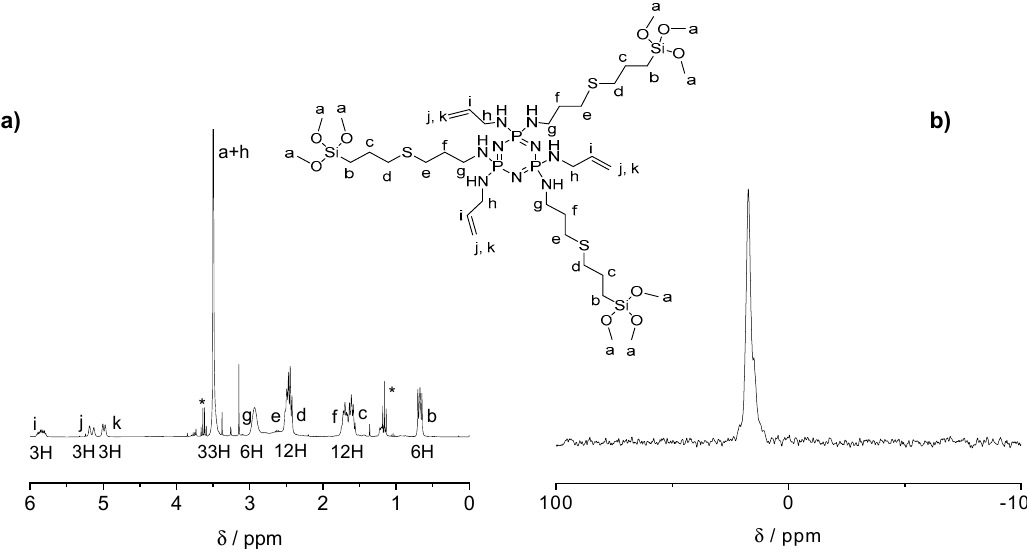
Figure 2. ( a ) 1 H NMR spectrum and ( b ) 31 P NMR spectra of the half-substituted precursor SiCPz2 in CDCl 3 (traces of EtOH marked with *).